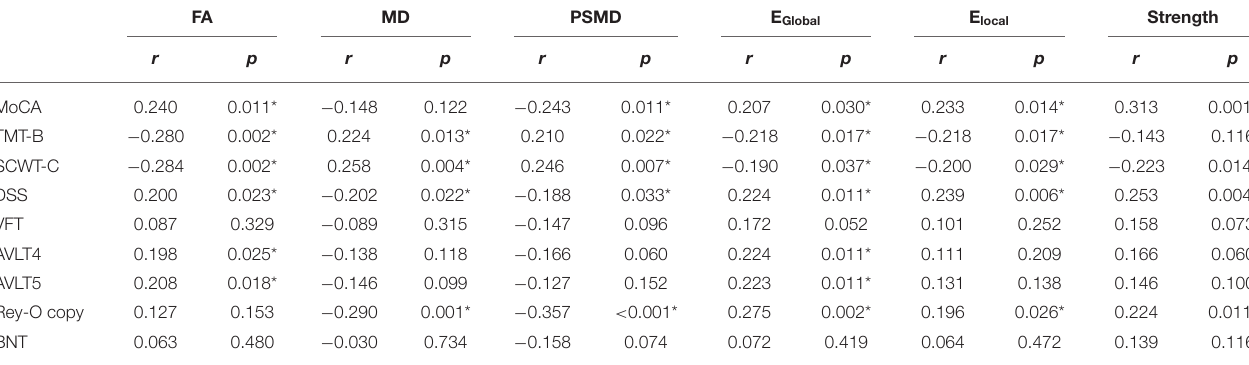
FIGURE 2 | Group difference of DTI measures. (A–F) One-way ANOVA test was applied to conduct the group comparison of DTI measures, p -value < 0.05 was considered to be statistically significant. * represents p -value < 0.05 after Bonferroni correction. VaMCI, CSVD with mild cognitive impairment; NCI, CSVD with no cognitive impairment; NC, normal control; FA, mean fractional anisotropy of the skeleton; MD, mean of mean diffusivity of the skeleton; PSMD, peak width of skeletonized mean diffusivity; E Global , global efficiency; E Local , local efficiency.